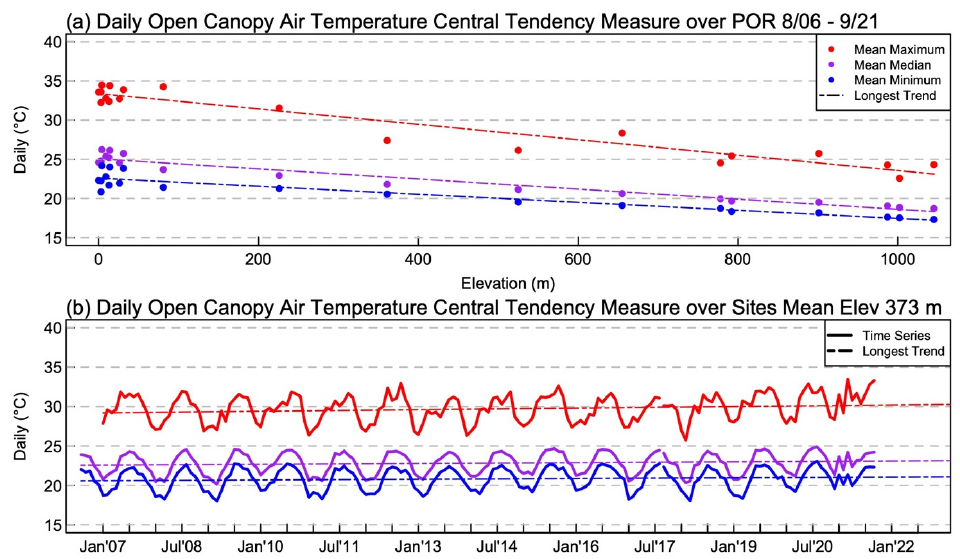
Figure 2. Average of the statistical calculations on the open-canopy air temperature for daily maxi- mum, median, and minimum. Plot ( a ) shows the site period of record average values as points with the trend lines of magnitude with elevation. Plot ( b ) shows the periodic component timeseries (each 1 month) averaged over the sites as thick lines, with thin dashed trend lines of magnitude with time at the average site elevation (373 m). The colors signify the same variable across the plots. Only the longest trend calculated is shown, from the entire record.